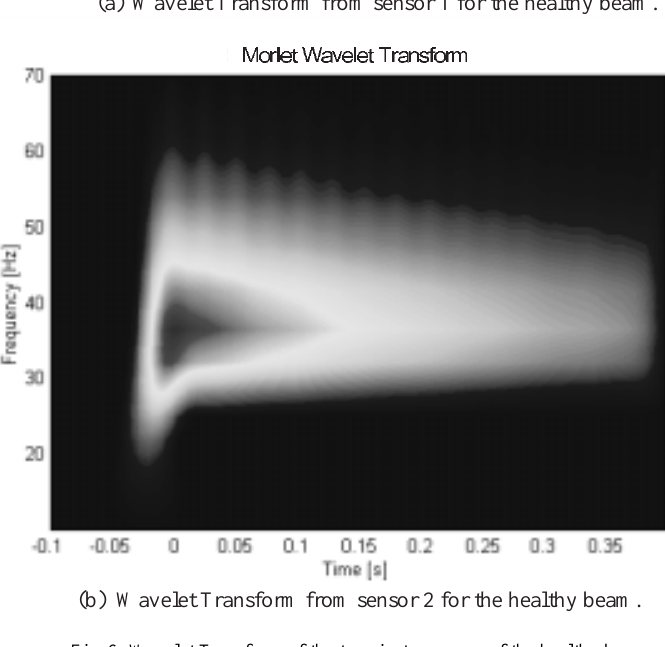
Fig. 6. Wavelet Transform of the transient response of the healthy beam. than the simulated damage beam in Fig. 2(b) at 38.1 Hz due to the stiffness reduction caused by the crack. Also, node 7 has higher displacement amplitude than node 5 for both cases, because cantilever deflection increases closer to the free-end of the beam. Figure 3 shows a WTF from the healthy and damage simulation at node 5 with S values of 0.9434 and 0.8366 from Eq. (17), respectively. The NDI from Eq. (18) is 0.1132, which confirms that stiffness changes within the beam are no- ticeable by this